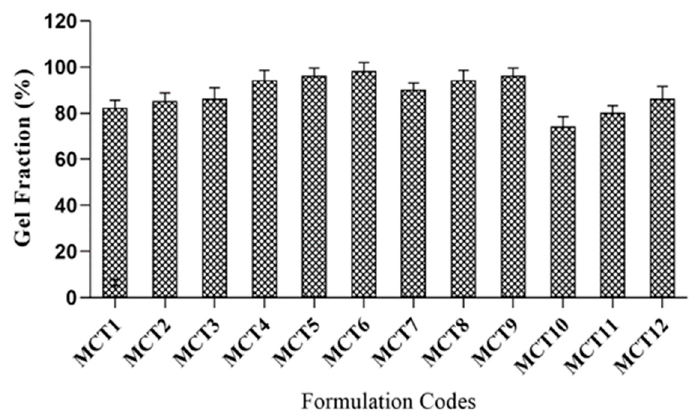
Figure 10. Gel fraction (%) results of developed formulations (MCT1–MCT12).